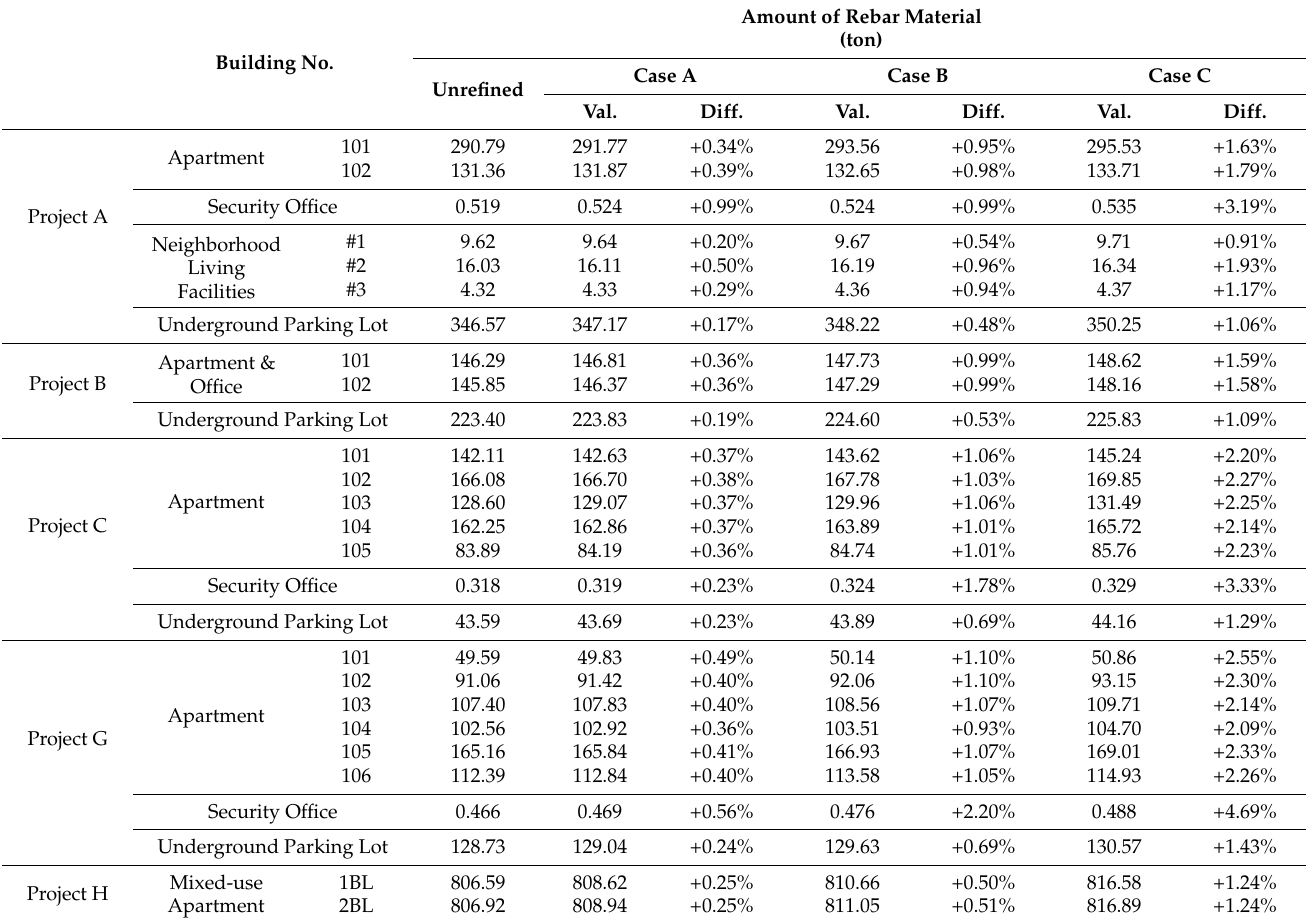
Table A8. Amounts of Rebar Materials for Slab Members and Differentials by